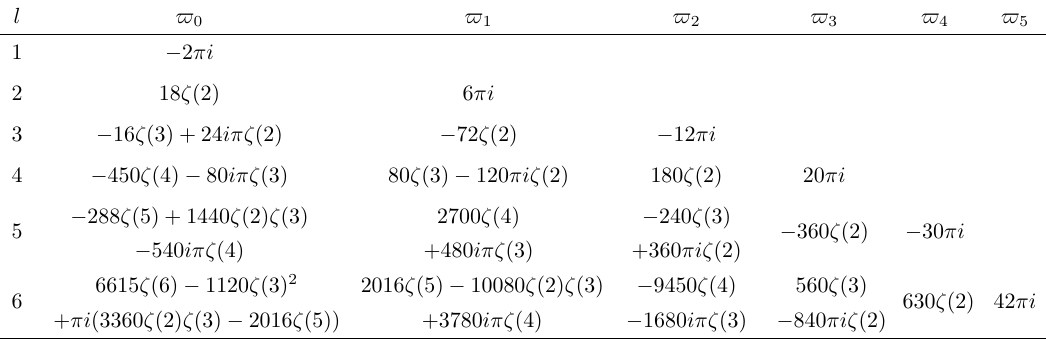
Table 2 . Numerically determined coefficients λ ( l ) Frobenius basis $ k at the MUM point for l ≤ 6